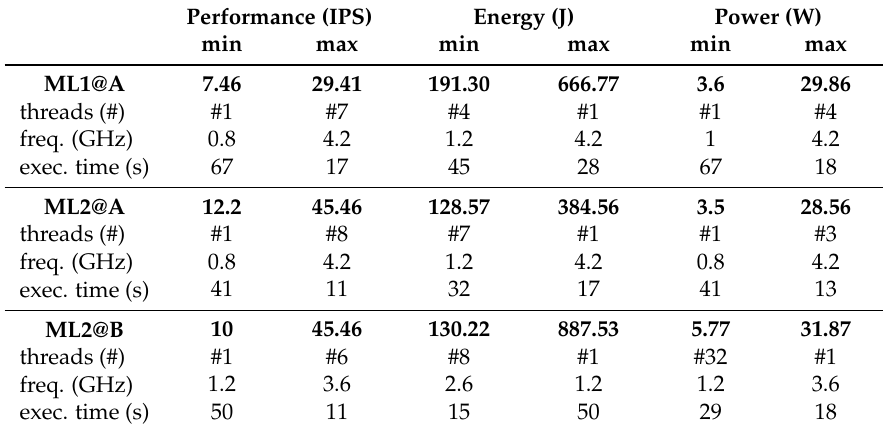
Table 6. ML—Energy and